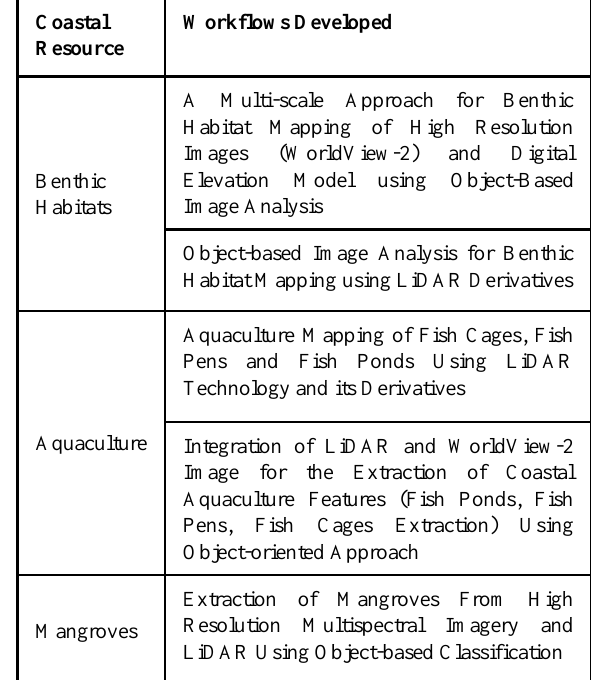
Table 1. Coastal resource mapping workflows developed by Phil-LiDAR 2